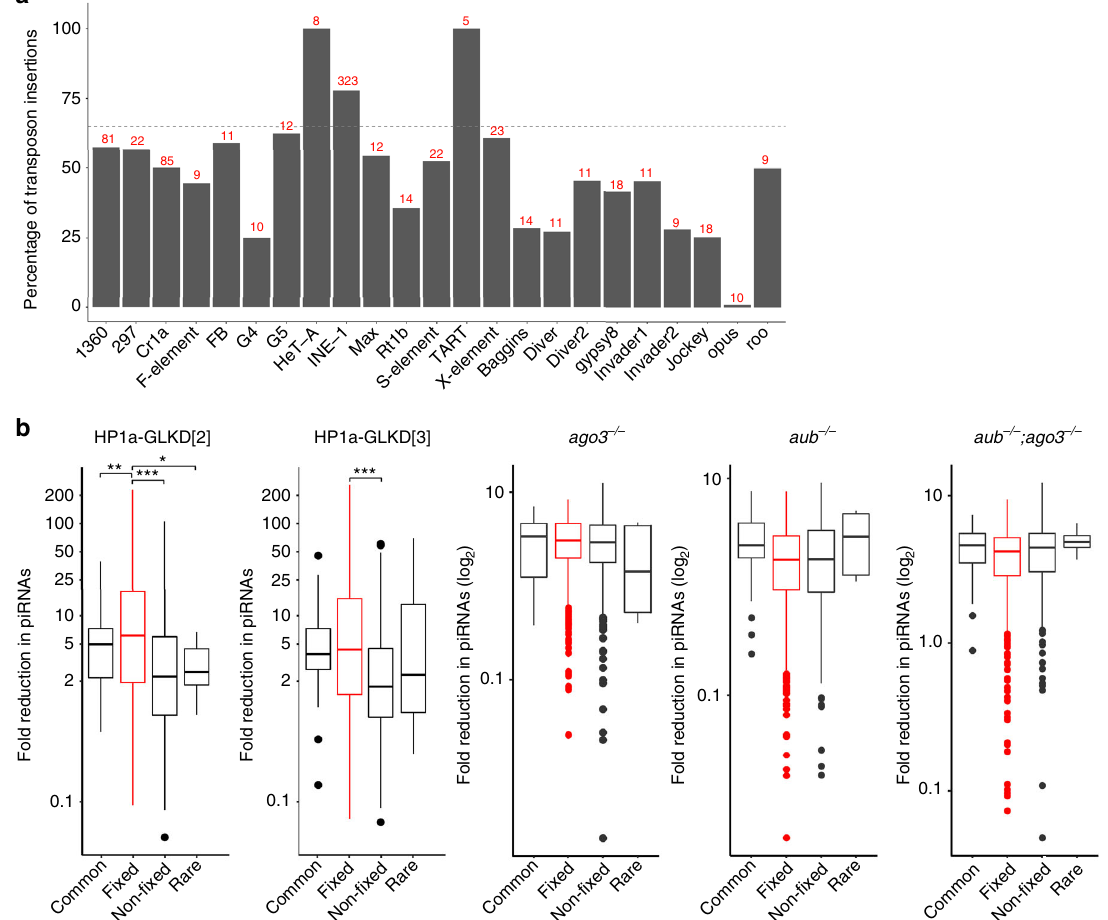
Fig. 5 HP1a is required for the biogenesis of piRNAs mapping to evolutionarily older transposons. a The percentage of the transposons insertions from major transposon families that showed at least three-fold loss in the uniquely-mapping piRNAs in the HP1a-GLKD ovaries. The average reduction between the 23~29-nt read levels in the HP1a-GLKD[2] and HP1a-GLKD[3] ovaries was plotted, and the insertions targeted by at least 20 unique piRNAs were considered. The number in red represents number of such insertions for each transposon family. b Boxplots showing the reduction in the piRNAs mapping to the evolutionarily fi xed, common, and rare transposon insertions, based on their occurrence in population, in the HP1a-GLKD and ago3 , aub , and aub-ago3 double mutants. The signi fi cance of higher reduction of piRNAs mapping to evolutionarily fi xed transposon insertions in comparison with those mapping to common or rare insertions was examined using Mann-Whitney U -test. The middle line represents median. Box represents 25 – 75 percentile range called inter quartile range (IQR). Upper and lower whisker extend highest or lowest values till 1.5 * IQR. Values above and below are outliers and